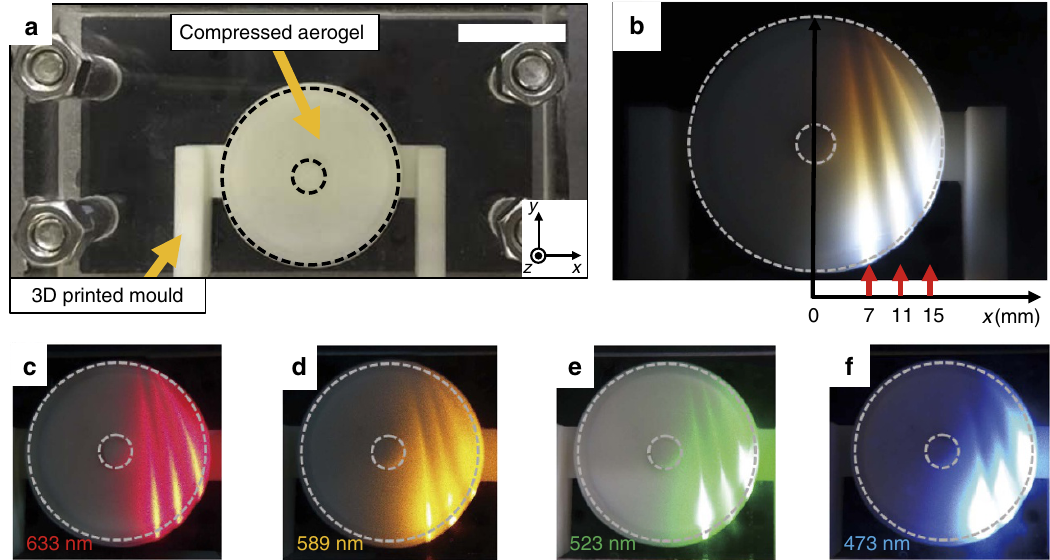
Figure 5 | Experimental demonstrations of a macroscale visible Luneburg lens. ( a ) A photograph of the Luneburg lens sample (33mm diameter) with a central hole (5mm diameter). The size of the scale bar, 20mm. Using the 3D printed pressing mould for Luneburg lens, we compressed the aerogel (dashed region), resulting in the designed distribution of compression ratio and effective refractive-index for the Luneburg lens in Fig. 3h. The aerogel prepared for the Luneburg lens sample has the following parameters: outer radius R 0 ¼ 16.5mm, inner radius r 0 ¼ 2.5mm and thickness t 0 ¼ 5mm. ( b ) White-light beams (red arrows) are incident in the y -direction at varying input positions in the x -direction (7, 11, 15mm). The light beam is redirected into a broad focal position at the output surface. ( c – f ) Various wavelength laser beams (633, 589, 523 and 473nm) are incident and redirected into a similar broad focal position on the output